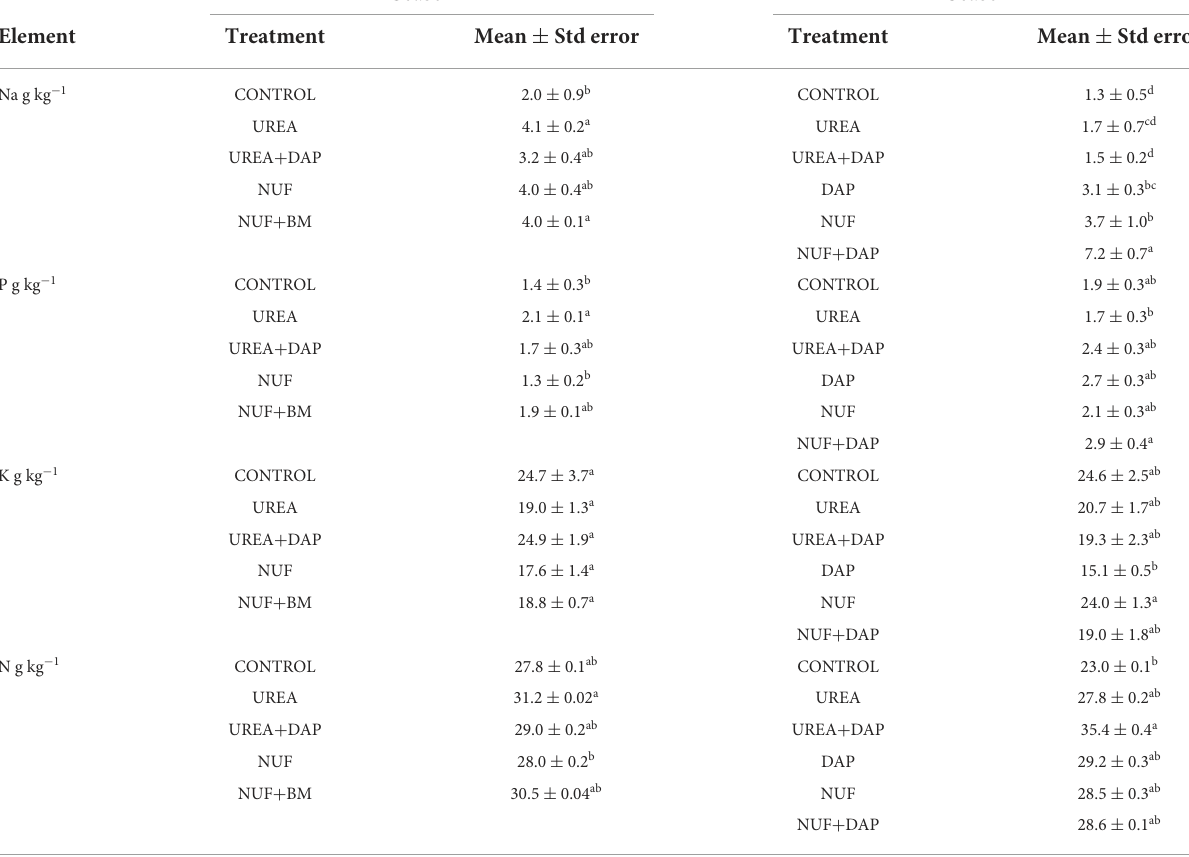
TABLE 3 Nutrient concentration in cabbage leaves (g kg − 1 dry